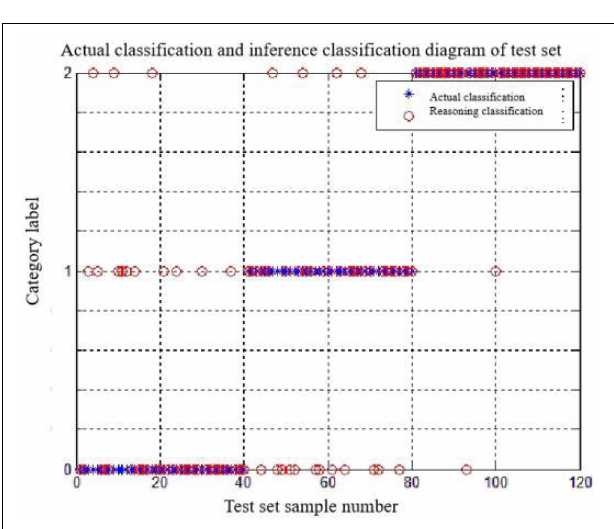
FIGURE 14 | The discrimination classification results for the test set.